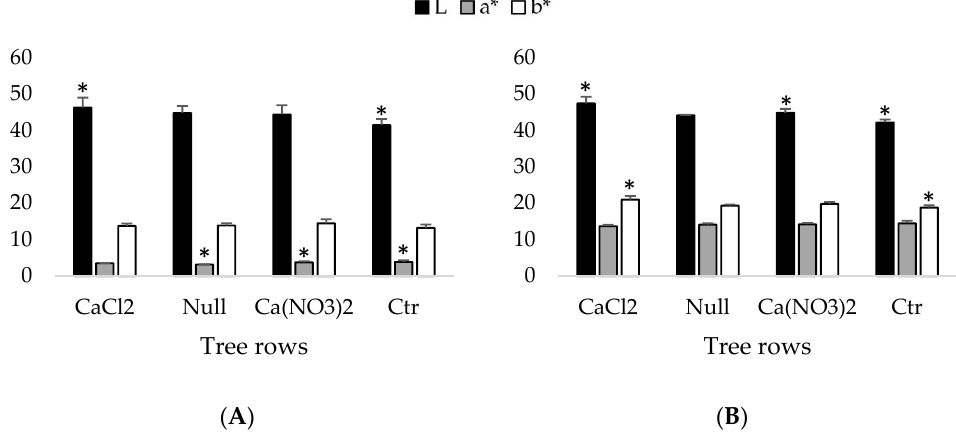
Figure 2. Average ( n = 3) of colorimetric parameters (L, a* and b*) for each tree row ( n = 4) from the orchard before ( A ) and after ( B ) organic matter removal. Asterisk (*) represents significant differences between tree rows for each color parameter.